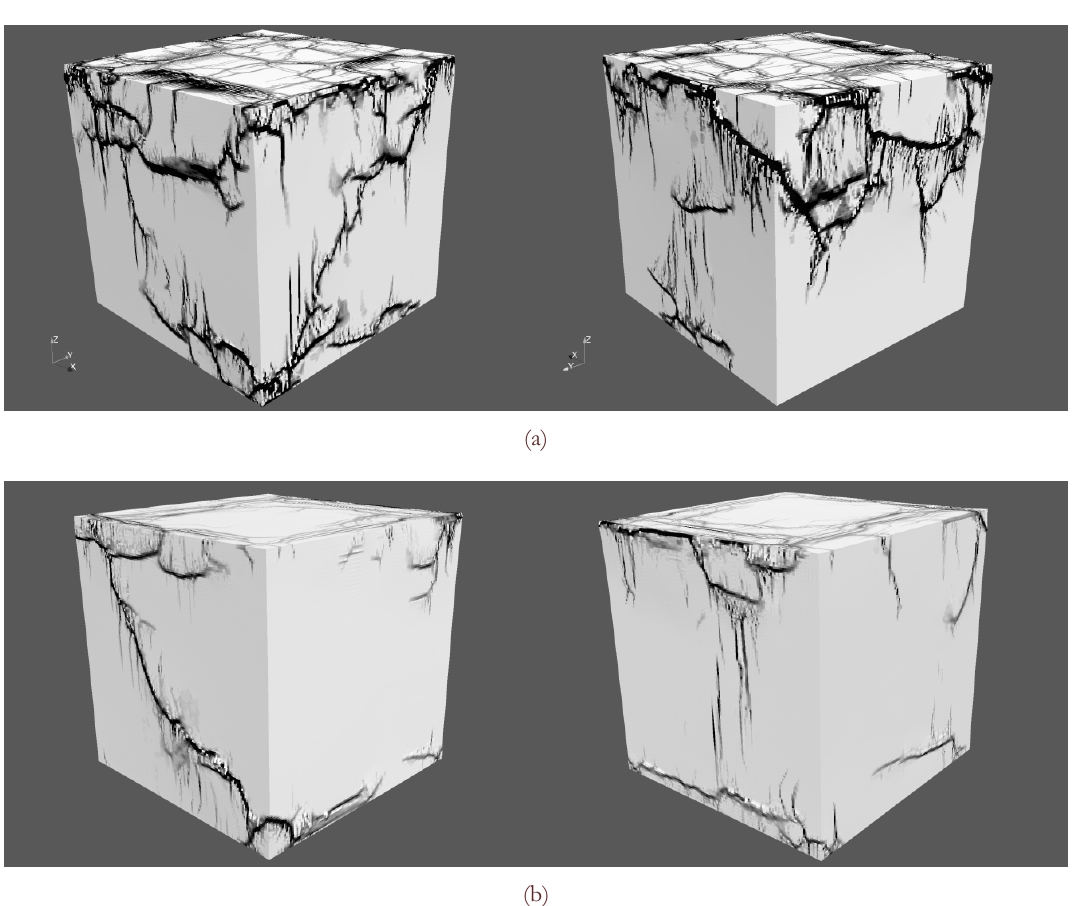
Figure 13: Simulation patterns: cracking of the ceramic composite with 15% content of hardening particles (2 views from opposite sides) at ideal sliding (a) and fixing (b) on the loading